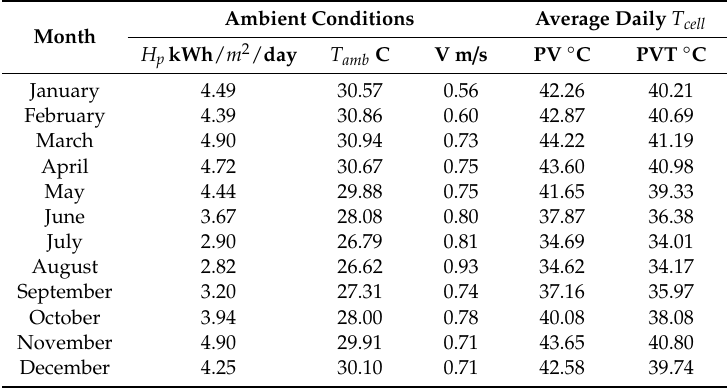
Table 3. A summary of weather data and module temperatures.